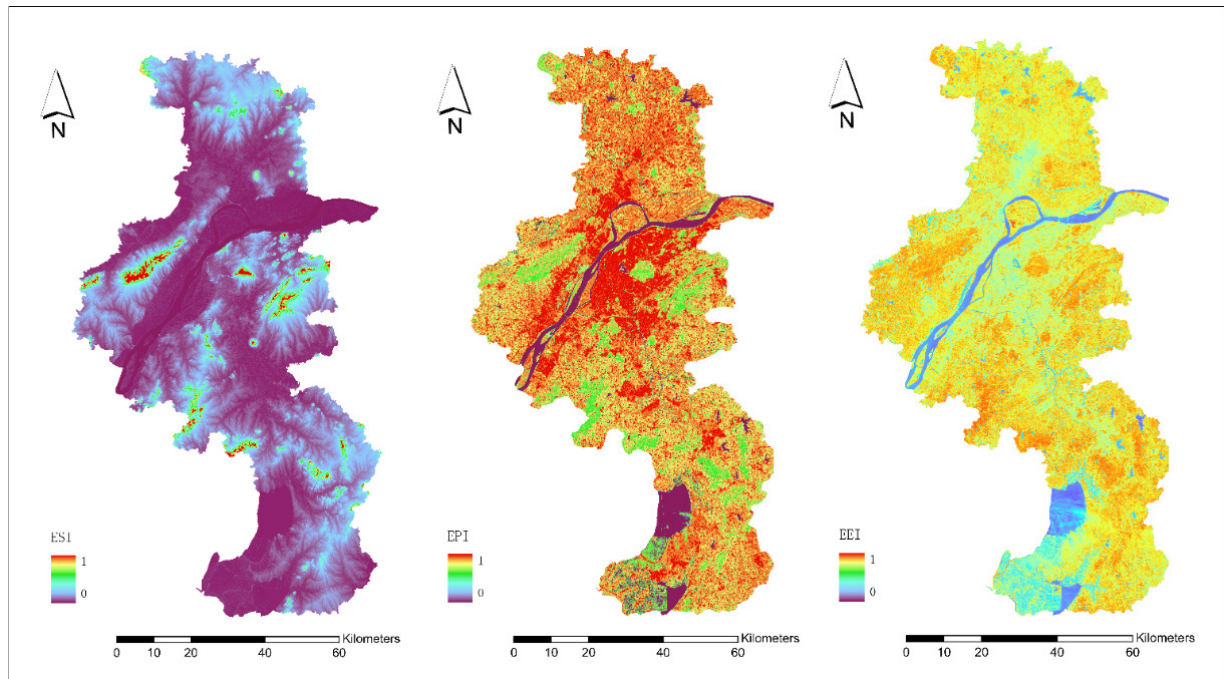
Figure 4. Standardised data results of three sub‐indexes of ecosystem vulnerability in Nanjing. disaster recovery ability. Ideally, these areas with low urban ecosystem vulnerability would be the preferred areas for future urban land development, regardless of other economic and social factors.